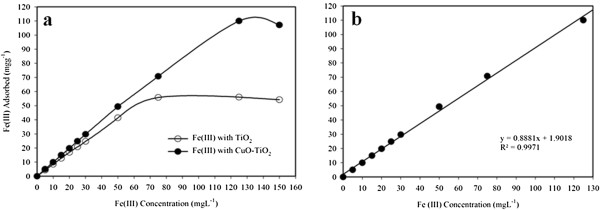
(a) Adsorption profile and (b) sensitivity of Fe(III) on 25.0 mg CuO-TiO2 NSs phase in relation to the concentration at pH 5.0 and 25°C.